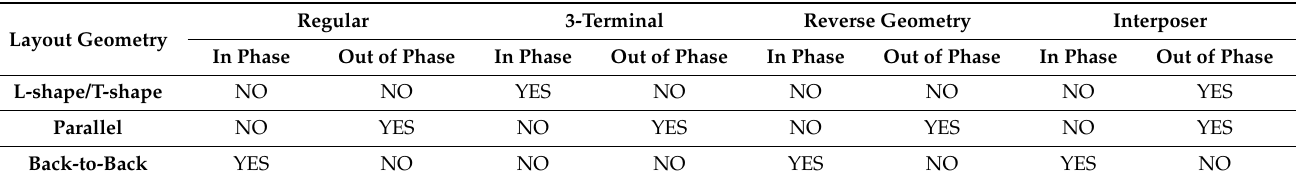
Table 1. Methods to reduce the acoustic noise created by